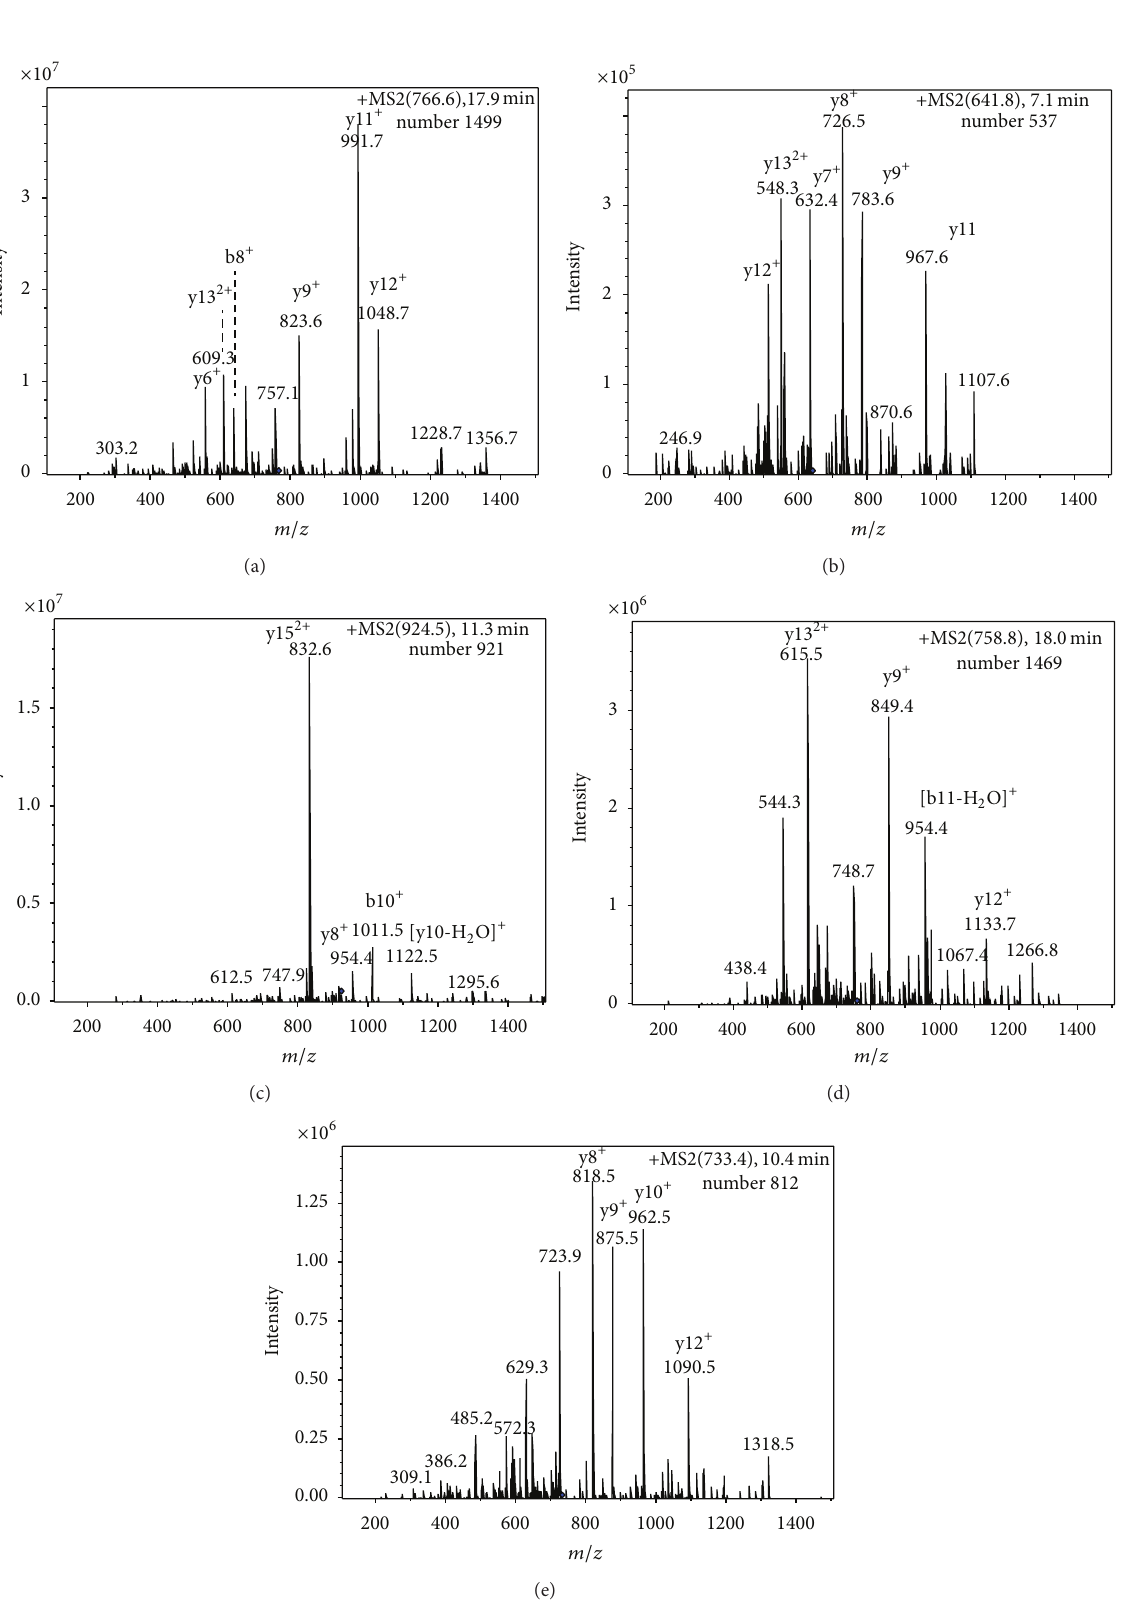
Figure 3: MS/MS fragmentation spectra of the ions at m/z (a) 765.8, (b) 641.8, (c) 924.5, (d) 758.8, and (e) 732.8 obtained by DCSI-MS/MS analysis, showing the fragment peaks that matched the expected peptide sequences. Gelatins were digested with